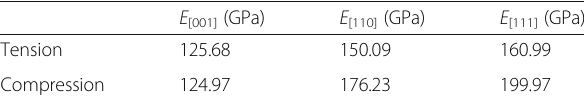
Table 1 E of samples under tension and compression along different orientations